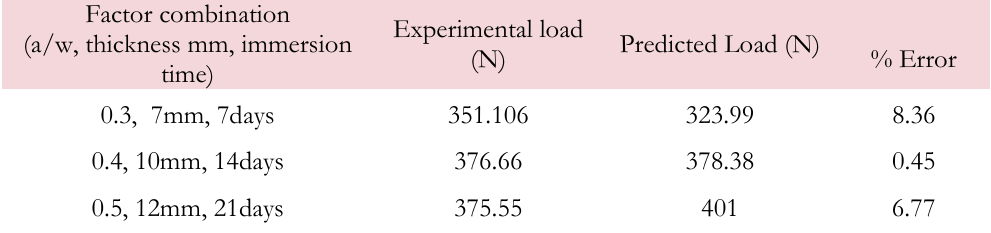
Table 7: Confirmation Test table for Load carrying capacity (N).